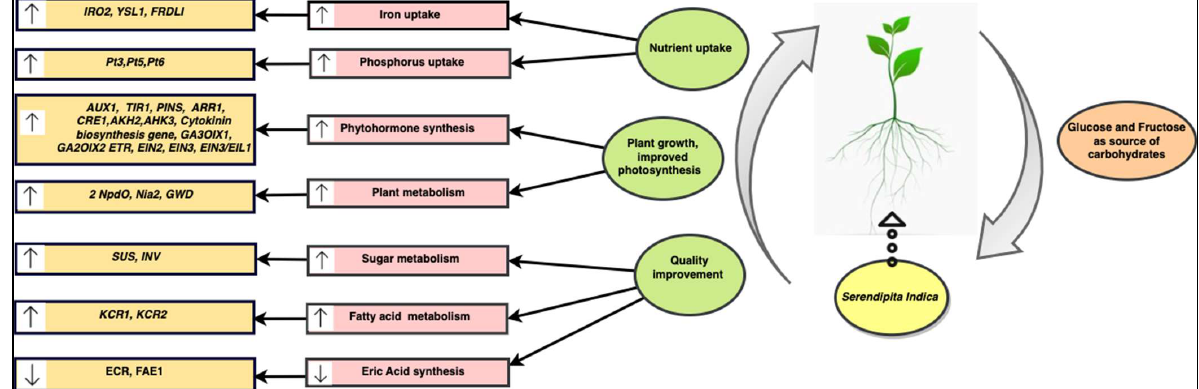
Figure 5. Mutual interaction of S. indica with host plant resulting in enhanced plant metabolism by regulating the plant growth mechanism at molecular level. Genes which exhibit a fundamental role in this process are AUX1 , PINS , TIR —auxin biosynthesis genes, AHK2 , AHK3 , CRE1 —cytokinin receptor genes, ARR —cytokinin-responsive gene, ECR —trans-2, 3-enoyl-CoA reductase, ETR , EIN2, EIN3 , EIN3/EIL1 —ethylene biosynthesis genes, FAE1 —3-ketoacyl-CoA synthase, FRDL1 , IRO2,